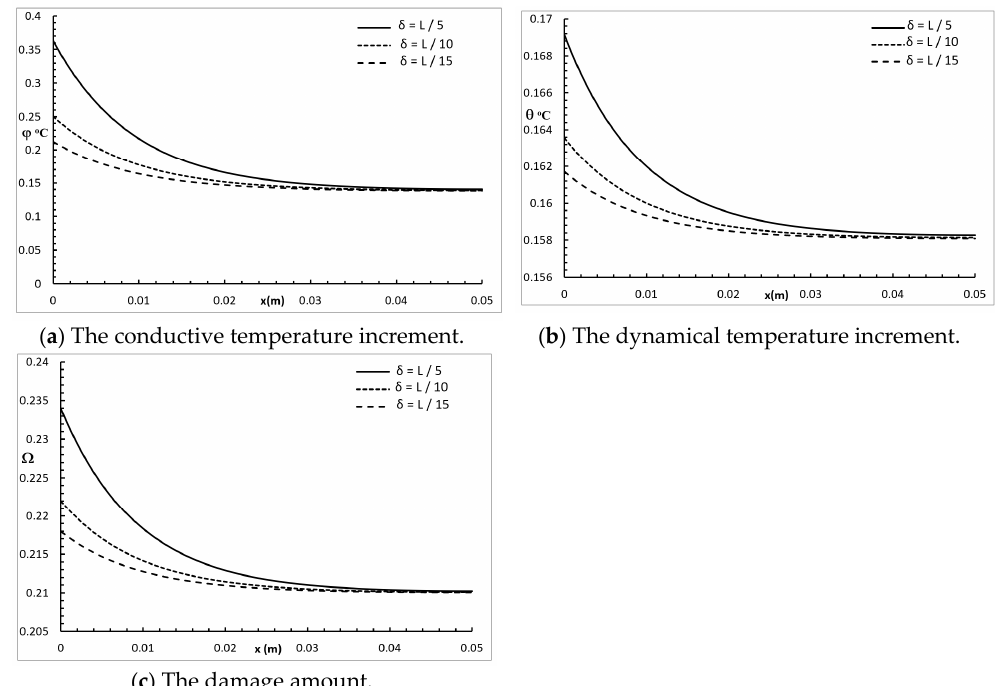
Figure 4. The studied functions for various values of the penetration depth parameter.